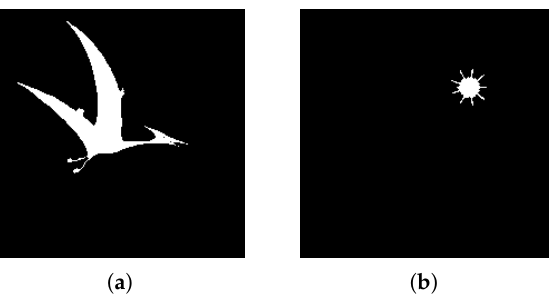
Figure 11. Experiment B extracted regions ( a ) Object A; ( b ) Object B.